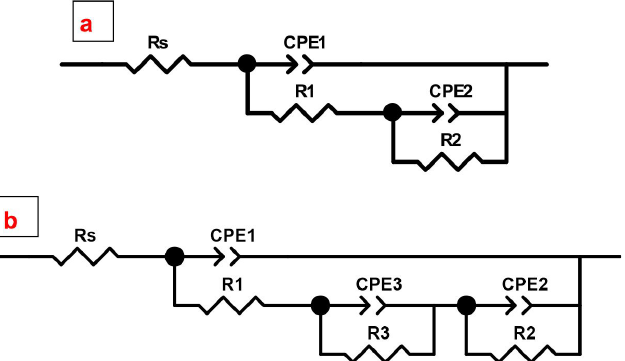
Figure 10. Equivalent electrical circuits (EEC) used for fitting the impedance spectra for PEO - , composite ( a ) and hybrid coatings ( b ) .